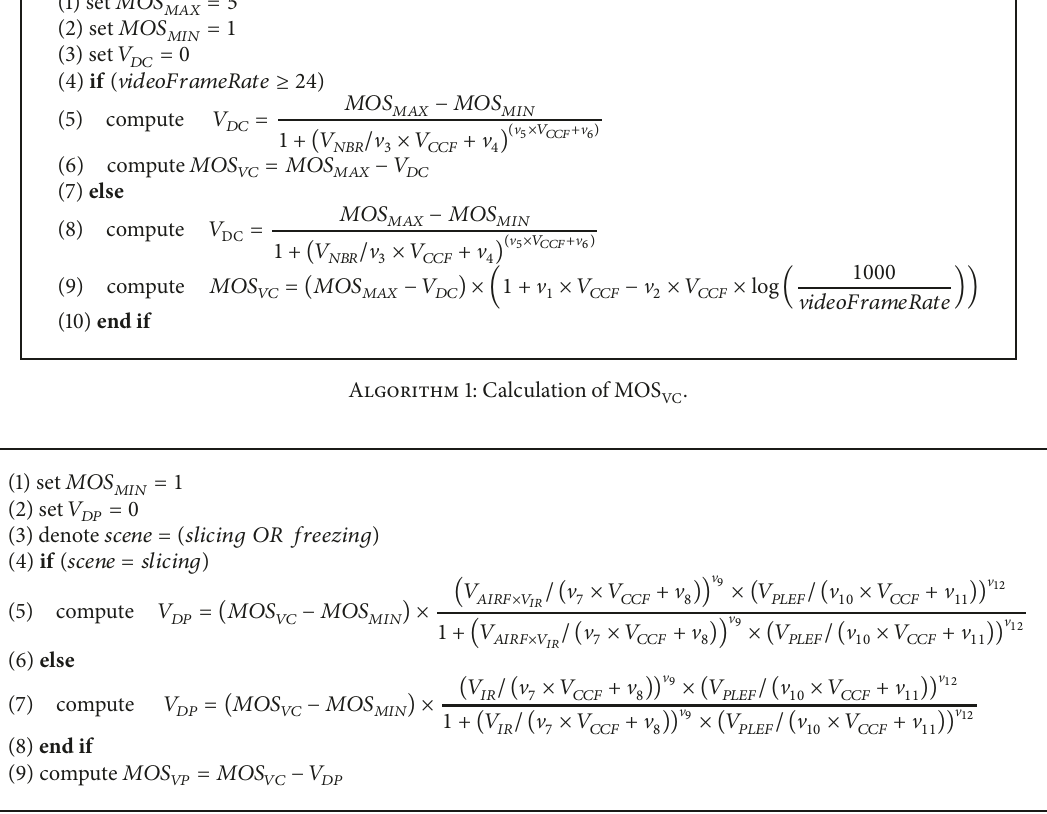
Algorithm 2: Calculation of MOS